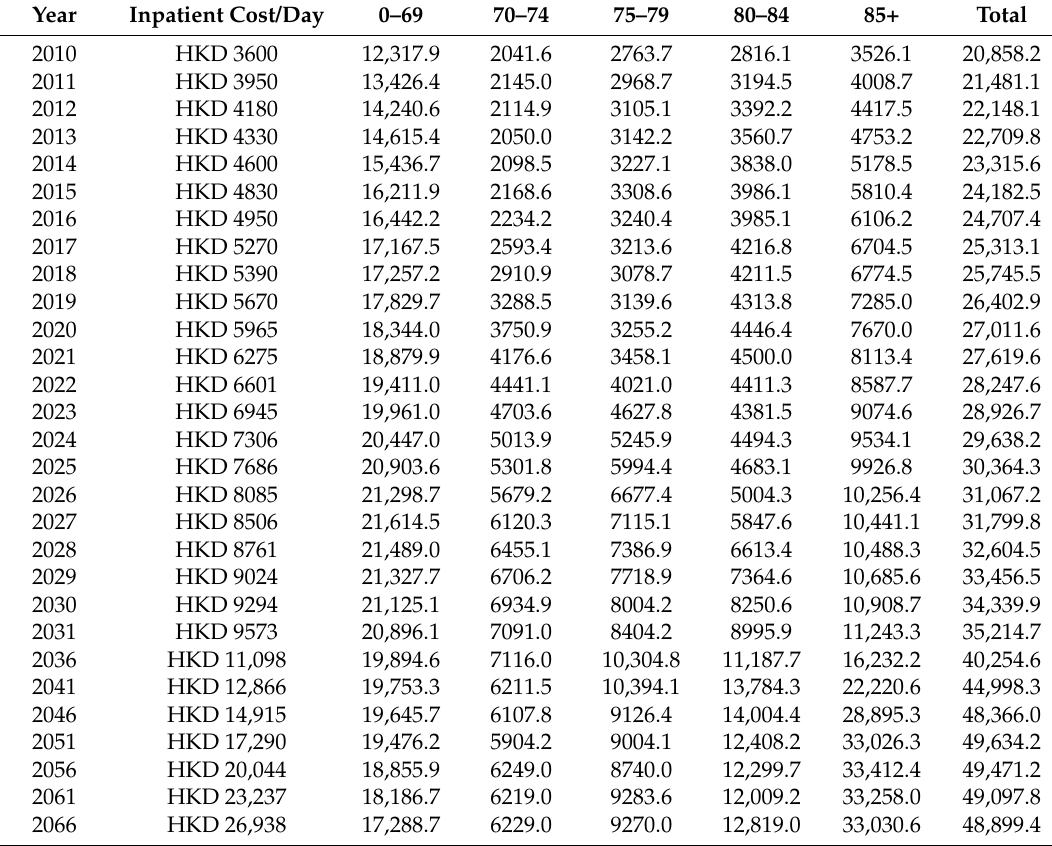
Table 1. Total discounted hospitalisation costs by age groups 2010–2066 (HKD